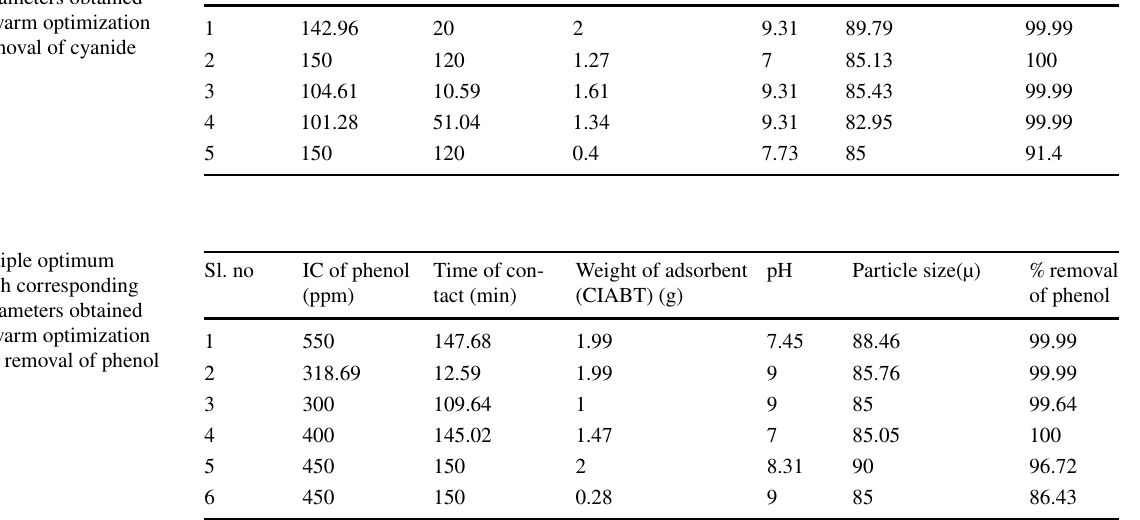
responses and corresponding operating parameters obtained by particle swarm optimization (PSO) for removal of cyanide